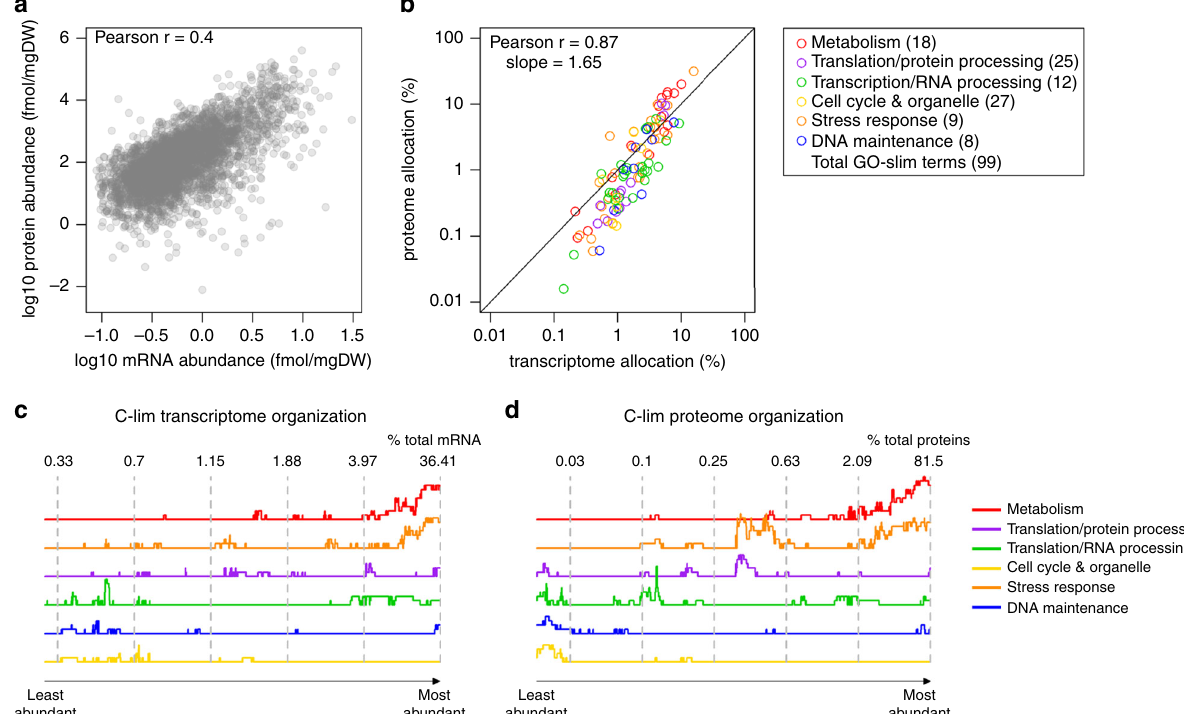
Fig. 1 Transcriptome and proteome allocation are better correlated at the process level than the gene level. a Absolute mRNA and protein abundances were quanti fi ed in yeast chemostat cultures at a dilution rate D = 0.2 h − 1 . Mean values of biological duplicates for the carbon-limited condition are shown. See Supplementary Fig. 2D-F for other conditions. b Transcriptome and proteome allocations to 99 GO-slim processes under carbon-limited condition were calculated as a % (mol mol − 1 ) of total transcripts and proteins. GO-slim processes are color-coded by functional category. The number of GO-slim terms curated in each functional category is shown. See Supplementary Data 2 for number of genes in each GO-slim term. c Enrichment of GO-slim terms in 200-gene sliding windows of relative transcript abundance was analyzed by Fisher ’ s exact test. Y-axis represents relative # of GO-slim terms belonging in each functional category with FDR-adjusted p Fisher < 0.05. Numbers indicate the relative abundance of transcripts (% mol mol − 1 of total transcripts) in the 200-gene window at the dashed lines. d As in c for proteome